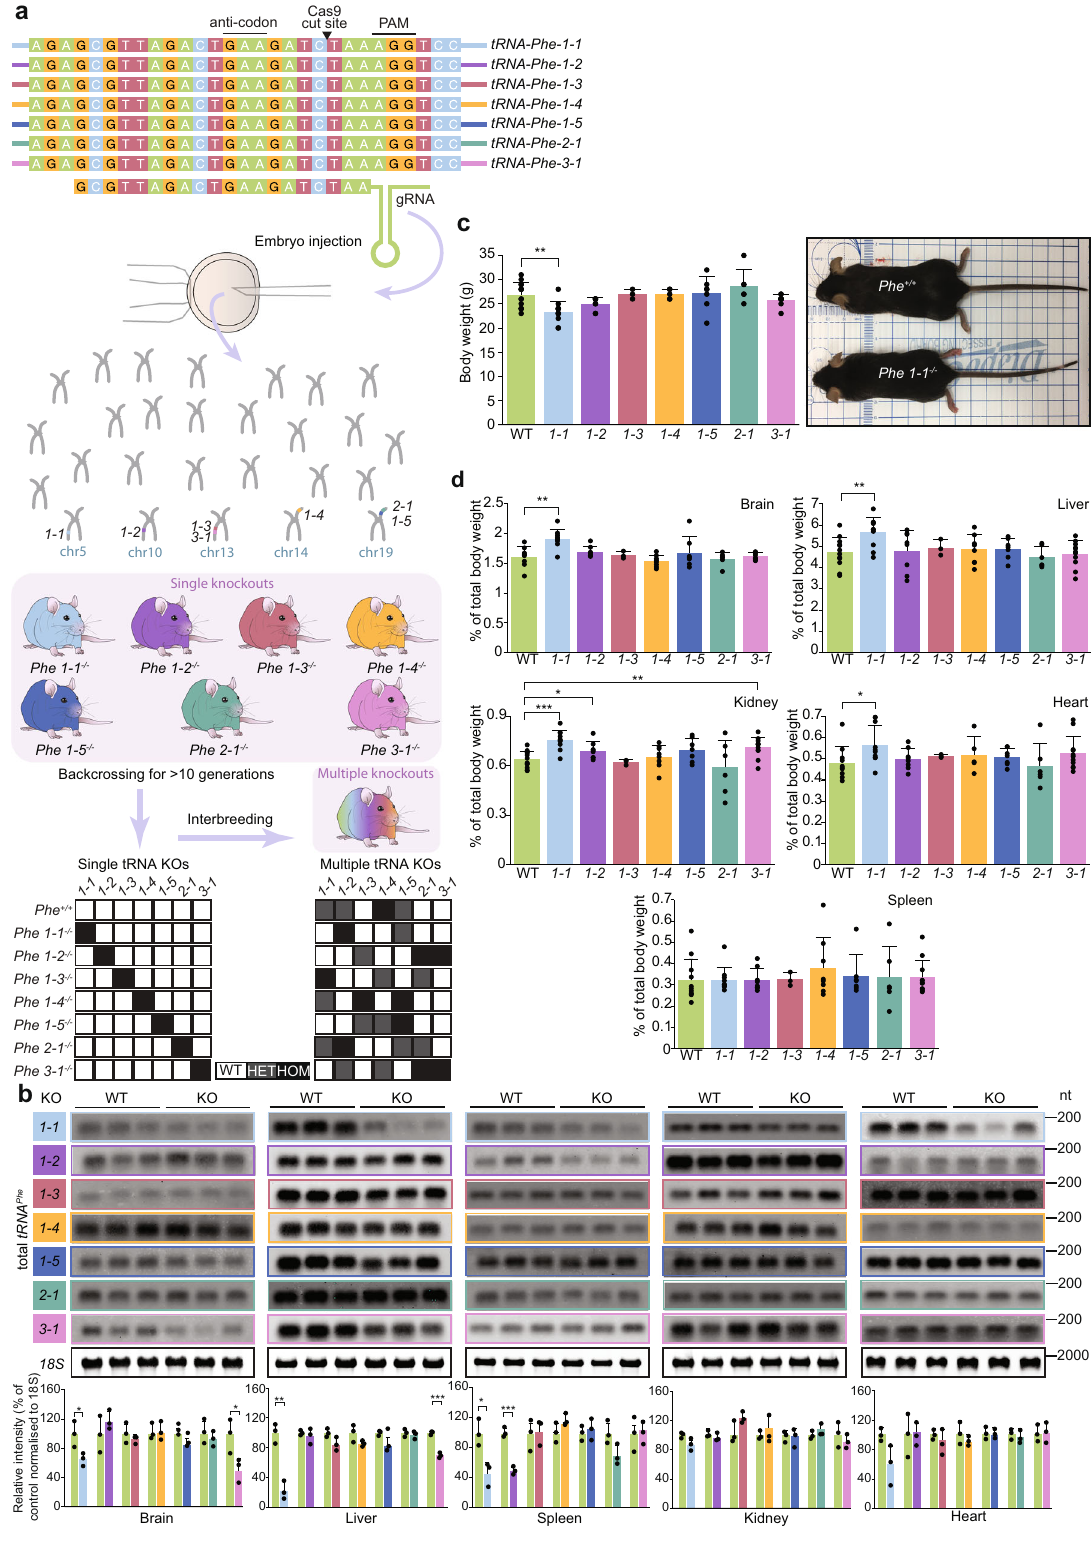
(Fig. 2b), consistent with the speci fi c deletion of the tRNA-Phe-1-1 -/- gene, validated by whole-genome sequencing (Supplementary Data 1). In addition, the loss of tRNA-Phe-3-1 -/- resulted in speci fi c reduction of tRNA-Phe levels in the liver and brain and loss of tRNA- Phe-1-2 caused a reduction of total tRNA-Phe levels in the